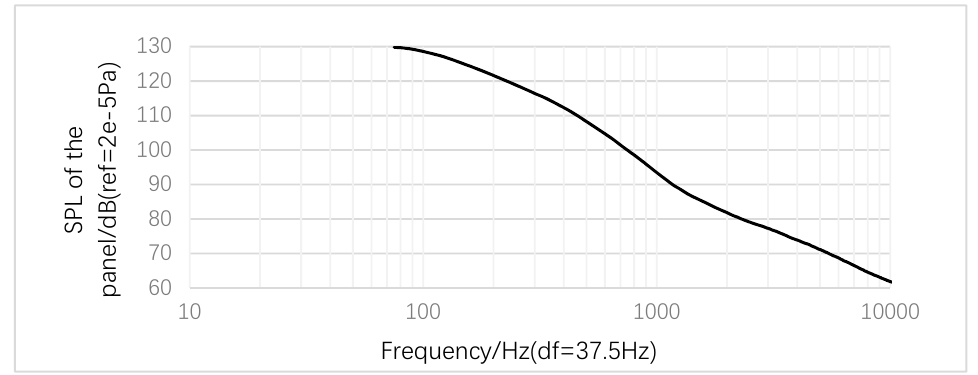
Figure 10. Spatial average pressure obtained by means of the Corcos model.